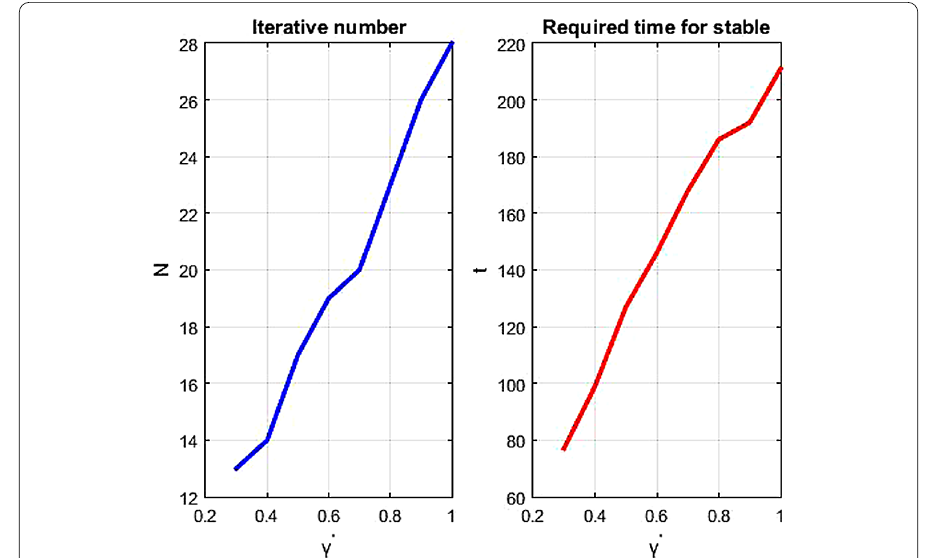
Figure 11 Iterative number and required time for stable with different γ (cid:3) ( γ = 0.0.4).